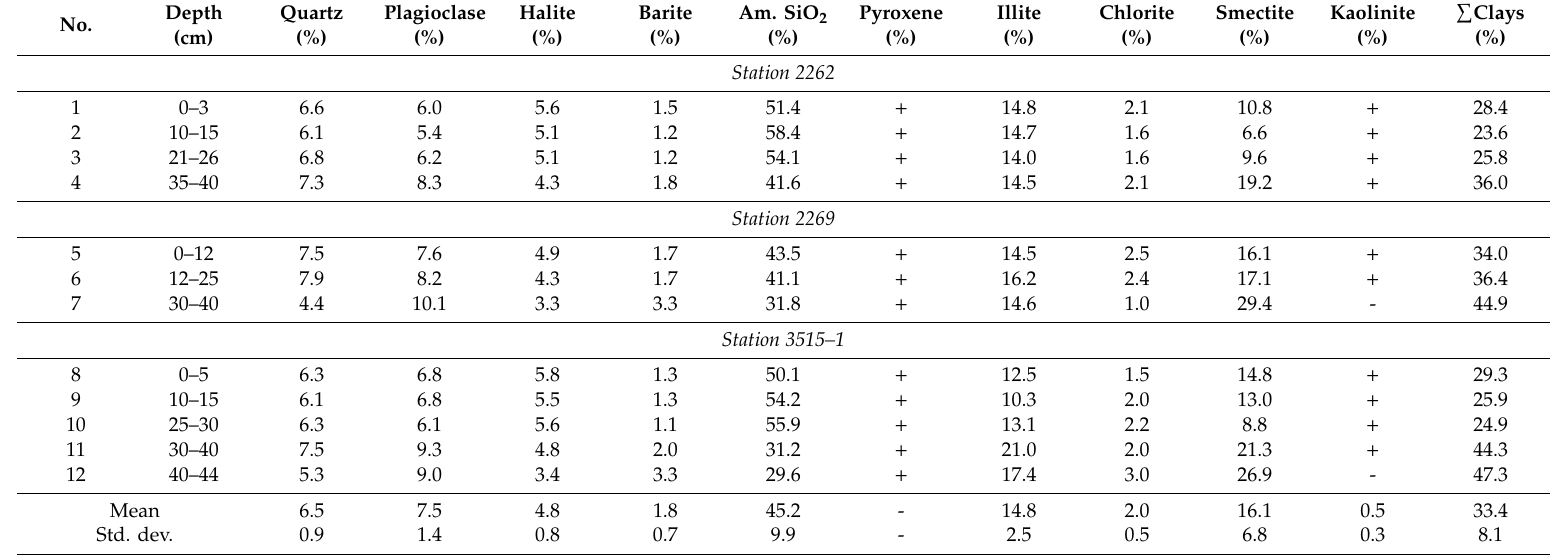
Table 7. Bulk X-ray di ff raction (XRD) data of the analysed pelagic sediments from the CCFZ, IOM claim area ( n = 12). The “ + ” signs indicate contents <